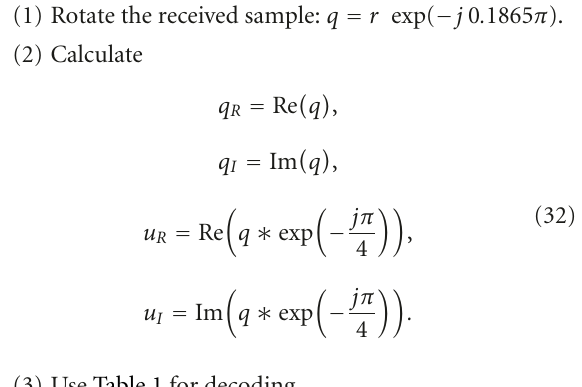
For hard decoding, each table entry denotes the decoded bits of TX1, TX2, and TX3 from left to right, respectively. For soft decoding, the distance between q and the